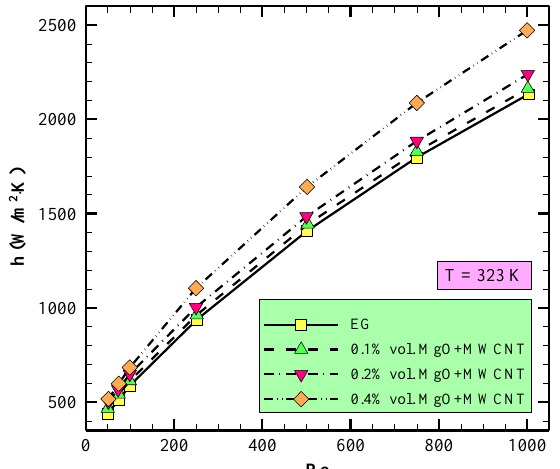
Figure 7. Influence of using HNF with different VF on HT coefficient for various Re and inlet temperature T = 323 K.